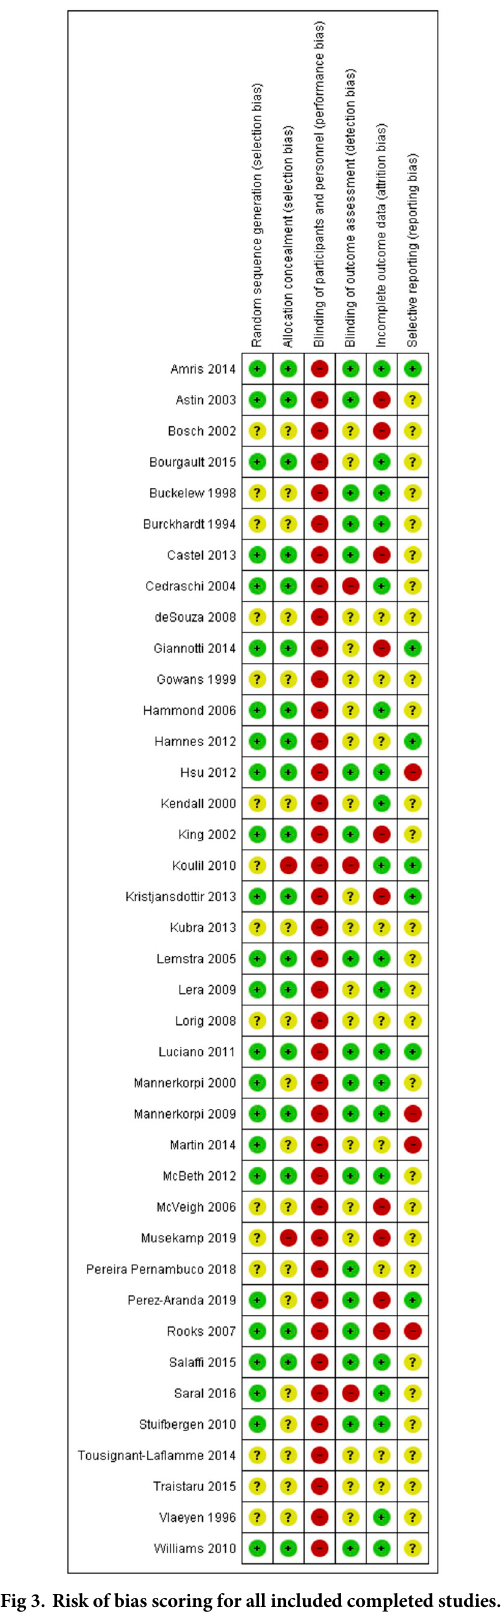
Fig 3. Risk of bias scoring for all included completed